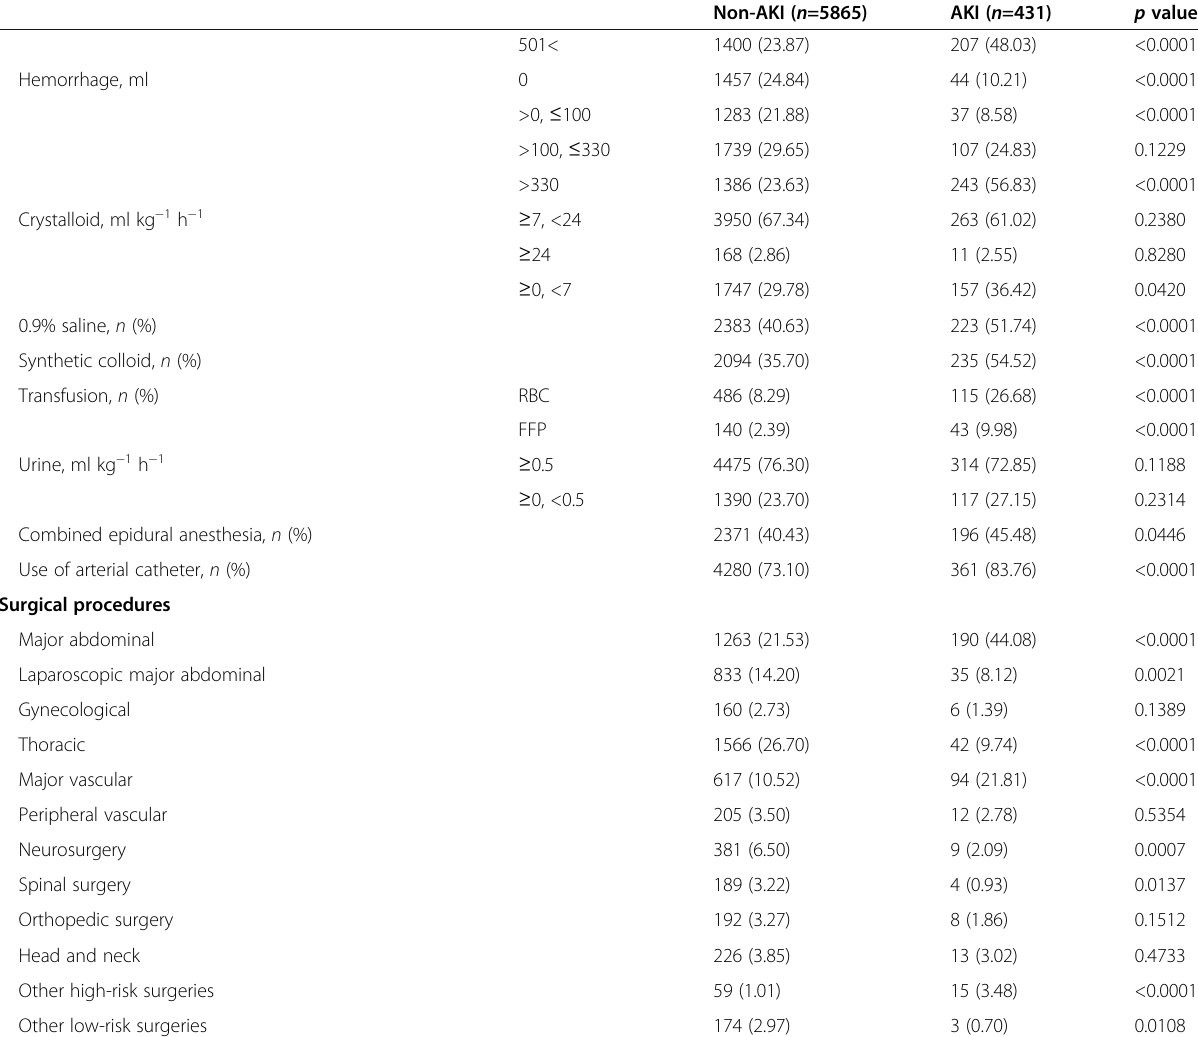
Table 1 Patients ’ baseline characteristics, coexisting medical conditions, intraoperative characteristics, and surgical procedures by acute kidney injury ( N =6296)